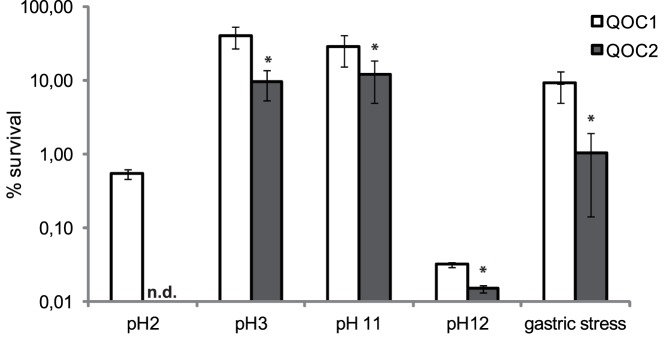
Survival of L. monocytogenes QOC1 and QOC2 in minimal media adjusted to pH 2, pH 3, pH 11 and pH 12; and in gastric fluid.Values, given as percentage of survival, represent mean values ± SD of four biological replicates performed in triplicate. *indicates statistical significant differences (P<0.05) between QOC1 and QOC2. n.d.: not detectable.